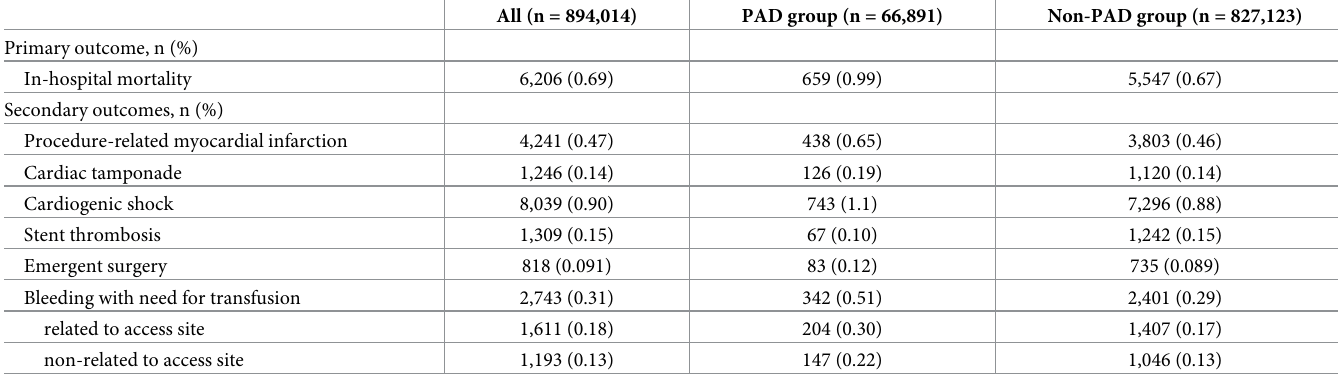
Table 3. In-hospital